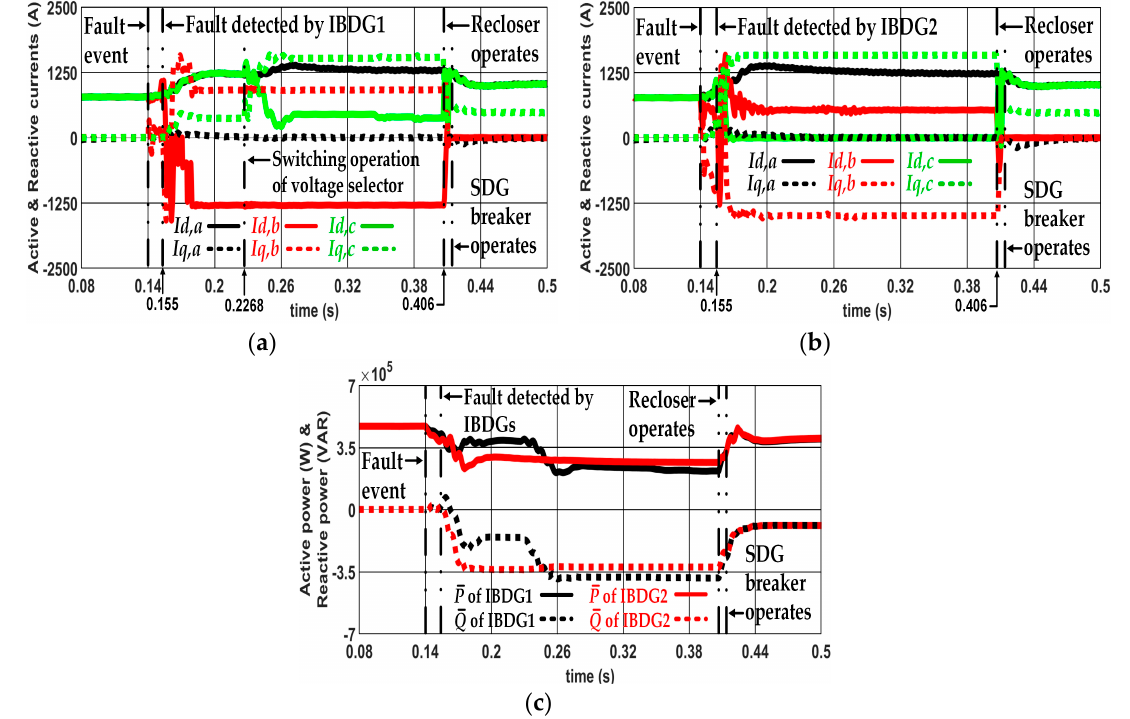
Figure 12. Separated phase–current controls during temporary SLG fault: ( a ) active and reactive currents of IBDG1; ( b ) active and reactive currents of IBDG2; and ( c ) average powers of all IBDGs.